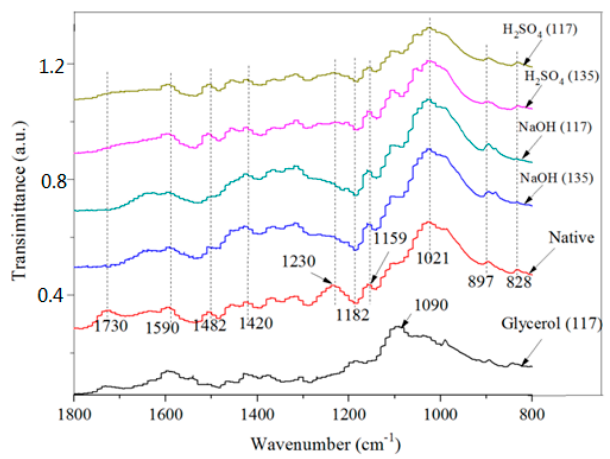
Figure 2. Infrared spectra of bamboo substrates before and after the pretreatments.